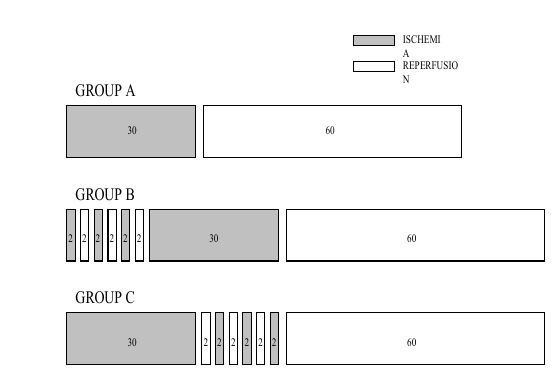
Ischemia and reperfusion periods schematic demonstration in the groups A, B and C (the numbers correspond to time in